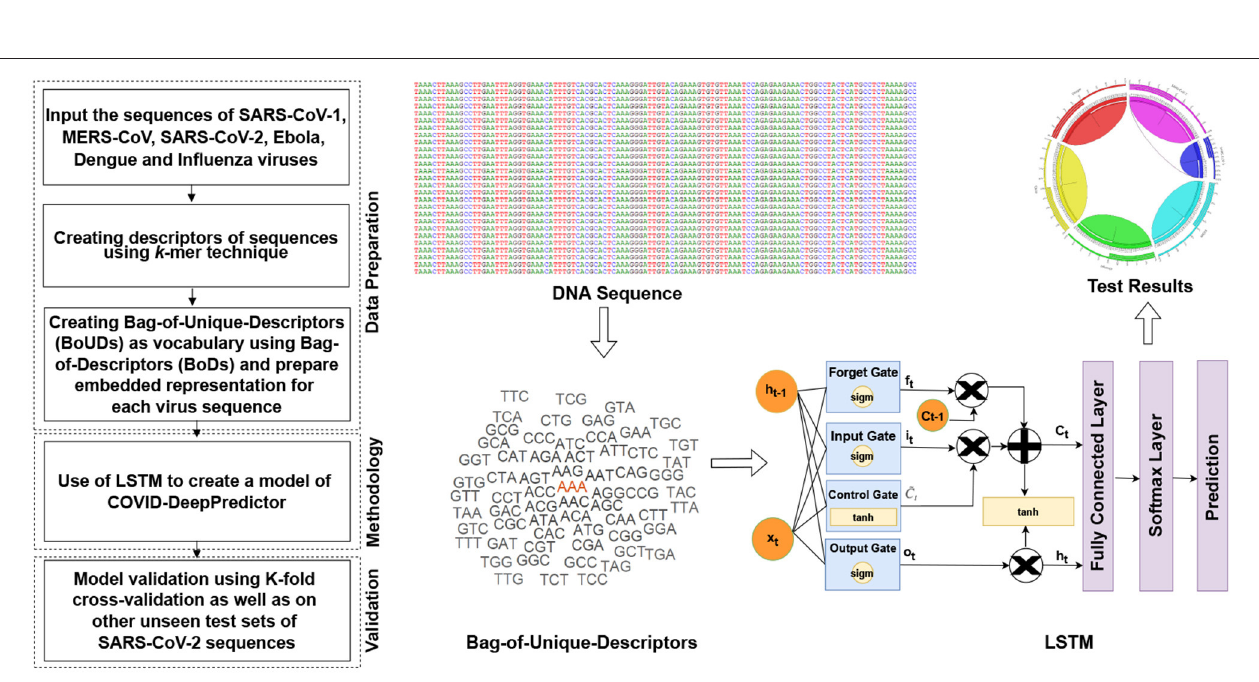
FIGURE 2 | Pipeline of COVID-DeepPredictor. The pipeline is depicted in the form of a flowchart and then represented diagrammatically where the symbols are defined as above.